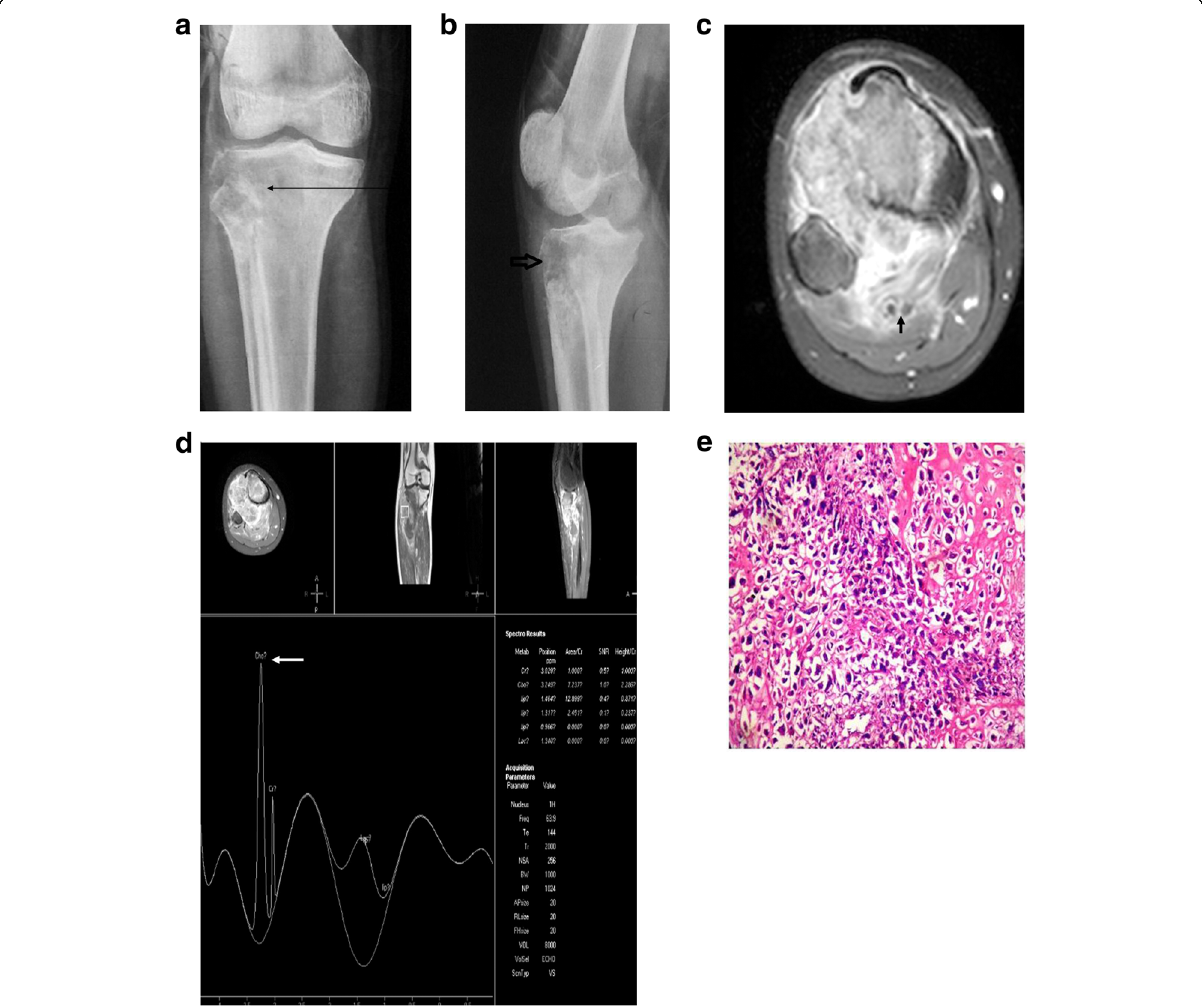
Fig. 1 21-year-old male patient. a . AP radiograph of the right knee. Irregular lytic lesion (black arrow) in the right proximal tibial epimetaphysis (arrow). b . Lateral radiograph of the right knee. The lesion is more conspicuous and shows cortical destruction (arrow). c . Post-contrast T1weighted axial image showing large destructive lesion with peripheral contrast enhancement. The associated soft tissue is causing popliteal vessel encasement (arrow). d . MRS shows a tall choline peak at 3.2 ppm (arrow). e . HNE 200× showing highly atypical stromal cells laying down osteoid suggestive of